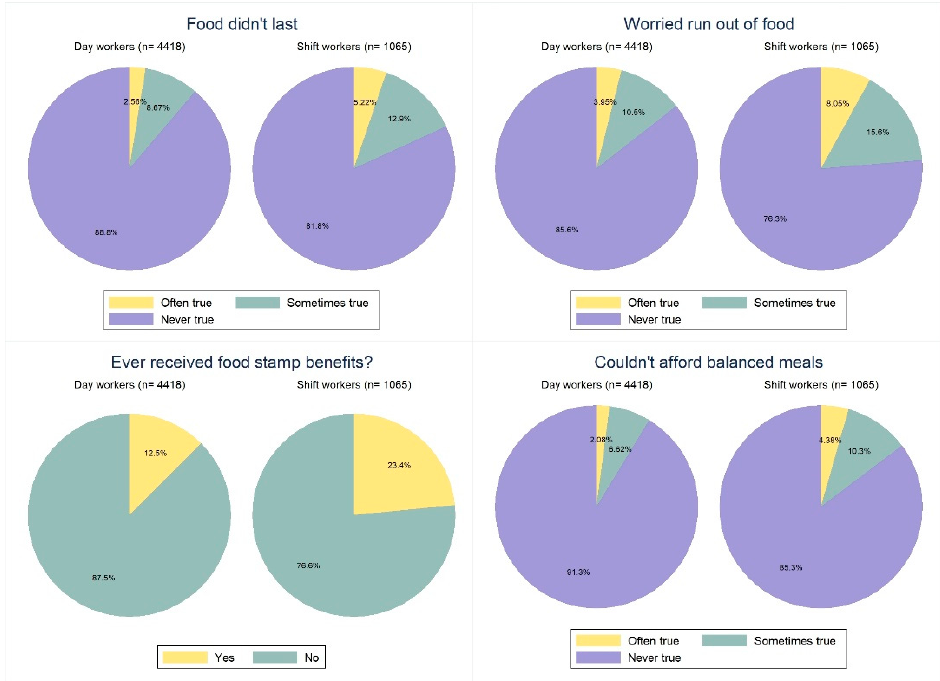
Figure 2. Food security in shift workers and day workers: a comparison regarding food stamp receipt, food concerns, affordability, and food sufficiency. Table 5. Logistic regression models investigating associations of shiftwork status and food security